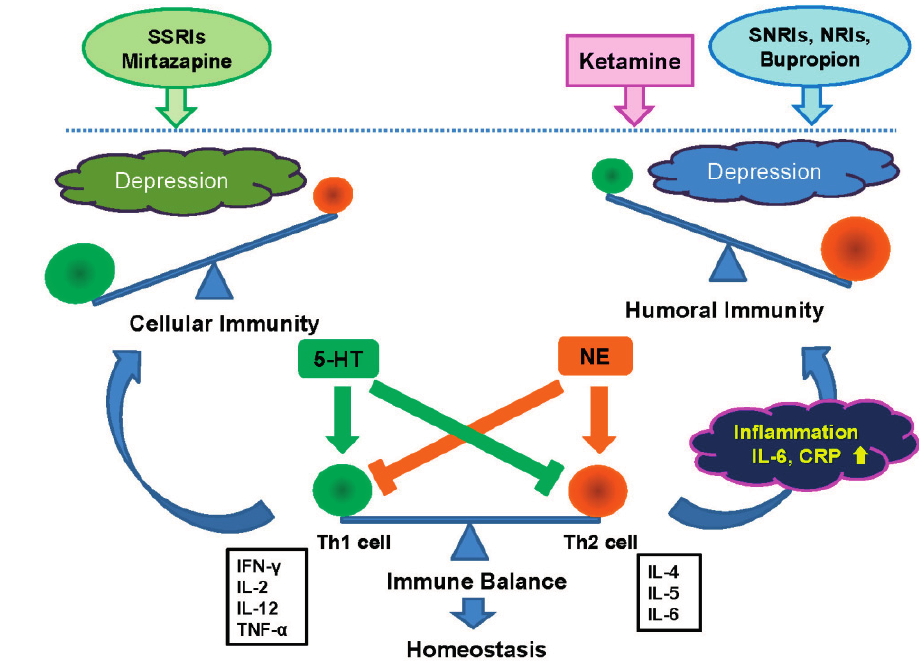
Figure 1. The balance between Th1 (cellular) and Th2 (humoral) response to the adaptive immune system. The immune system, composed of Th1-mediated cellular immunity and Th2-mediated humoral immunity, is essential to maintain health. Both Th1 and Th2 immunity are tightly controlled, but abnormalaties of the “immune balance” between Th1 and Th2 immunity is implicated in the pathophysiology of MDD. Th2 shift causes inflammation and increase in CRP protein and pro-inflammatory cytokines (e.g., IL-6), resulting in depressive symptom. Th1 shift also causes depressive symptom. 5-HT and NE are known to confer differential effects on inflammation. 5-HT and NE mediate a Th1 shift and a Th2 shift, respectively. Furthermore, 5-HT inhibits the production of Th2 cytokines such as IL-6, whereas NE inhibits production of Th1 pro-inflammatory cytokines, including TNF- α [18]. The SSRIs (e.g., paroxetine, sertraline, fluoxetine, escitalopram) cause a Th1 shift. The SNRIs (venlafaxine, duloxetine), and NRIs (nortriptyline, reboxetine) cause a Th2 shift [18]. Bupropion and mirtazapine may induce Th2 and Th1 shift, respectively [18]. In addition, the NMDA receptor antagonist ketamine may cause a Th2 shift. Thus, the regulation of the “immune balance” between Th1 and Th2 immunity is critical for therapy of